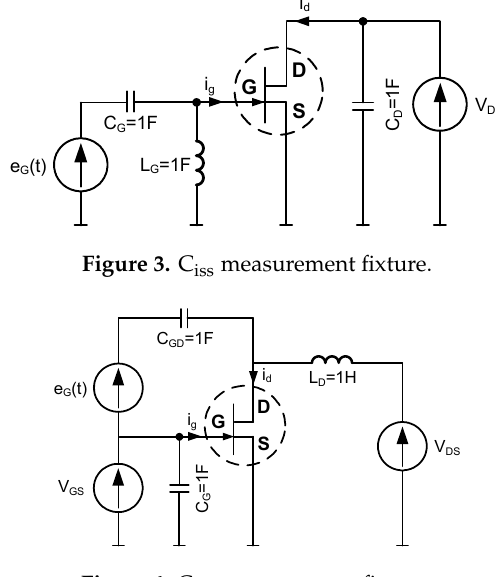
Figure 3. C iss measurement fixture.